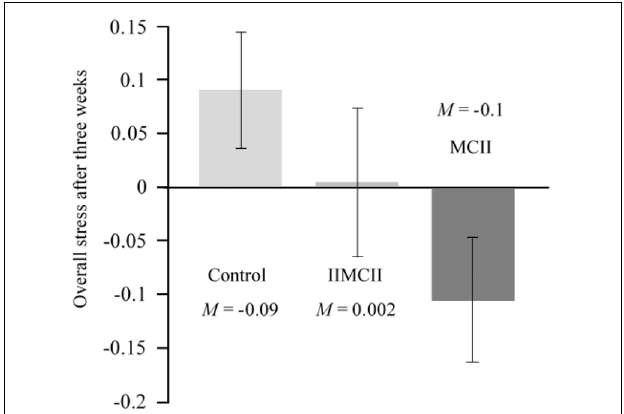
FIGURE 4 | Overall stress after 3 weeks assessed by the Perceived Stress Questionnaire (PSQ-20) and the Burnout Screening Scales II inventory (BOSS II) in the three groups of the intervention study, controlling for baseline scores.